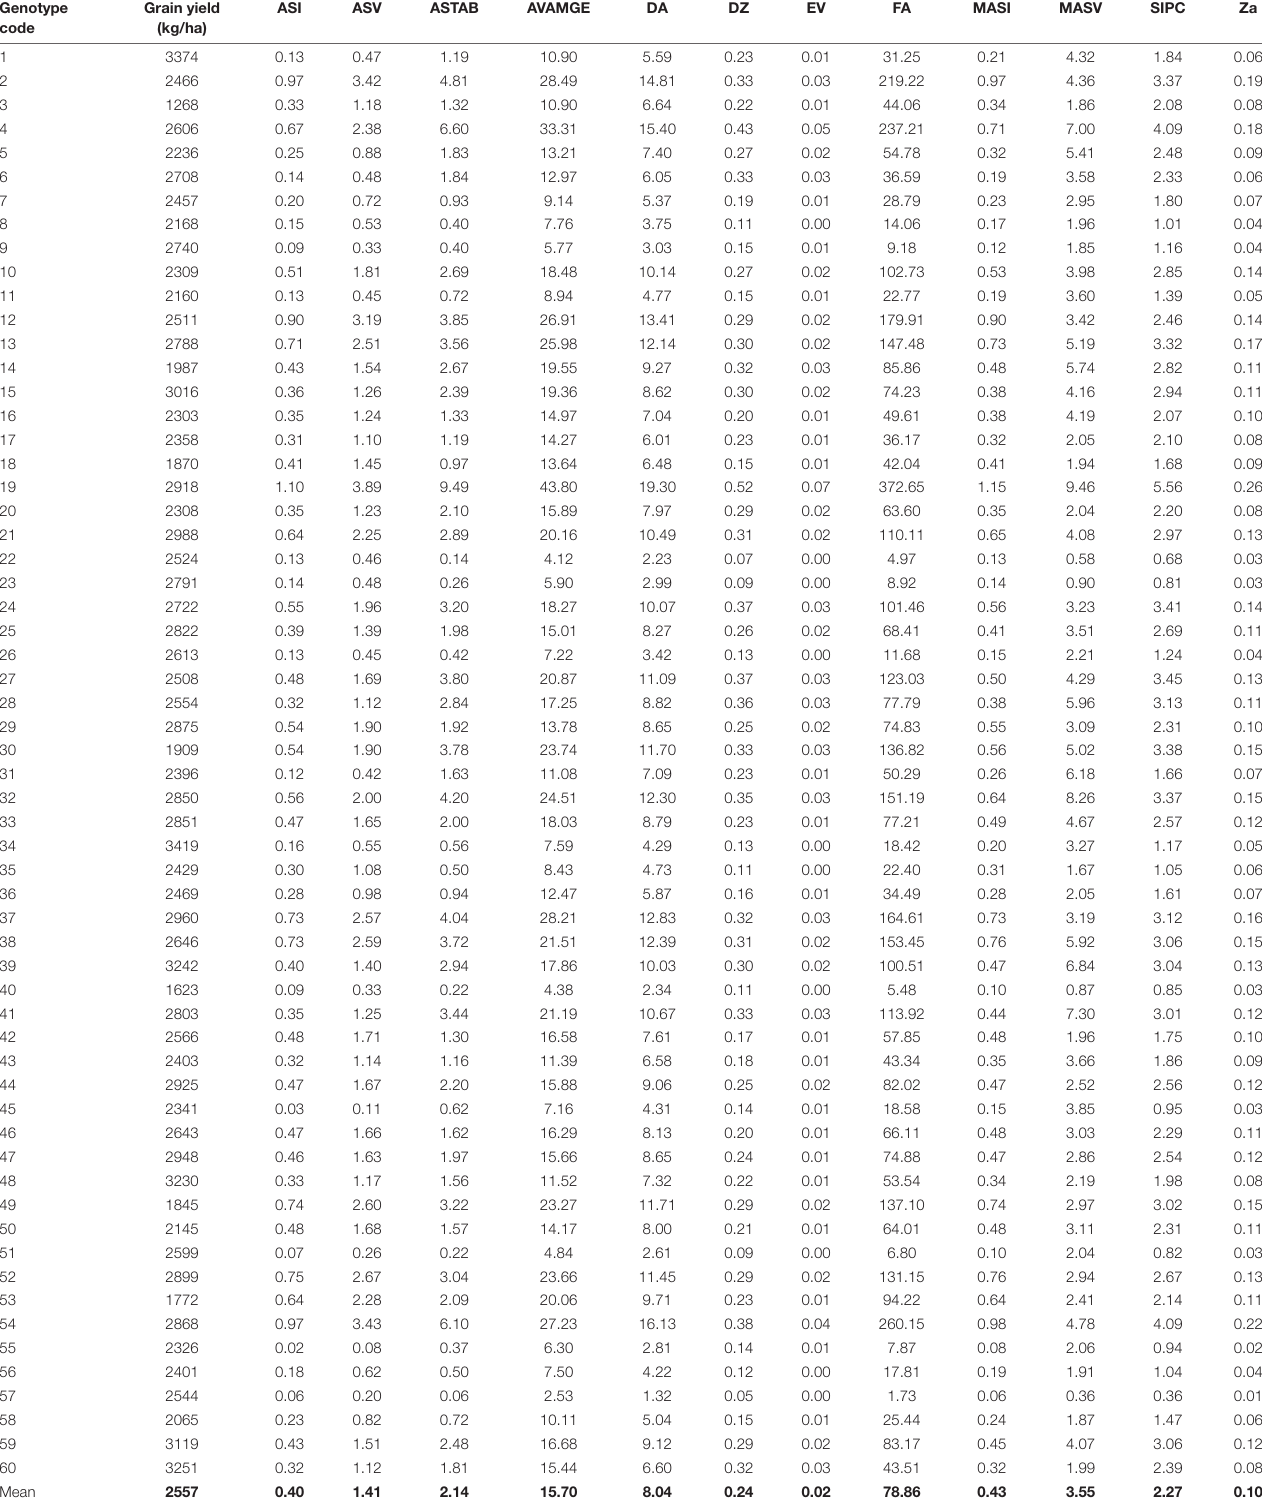
TABLE 3 | Various stability parameter estimates of 60 finger millet genotypes evaluated under six test environments during the main seasons of 2011–2016. Genotype